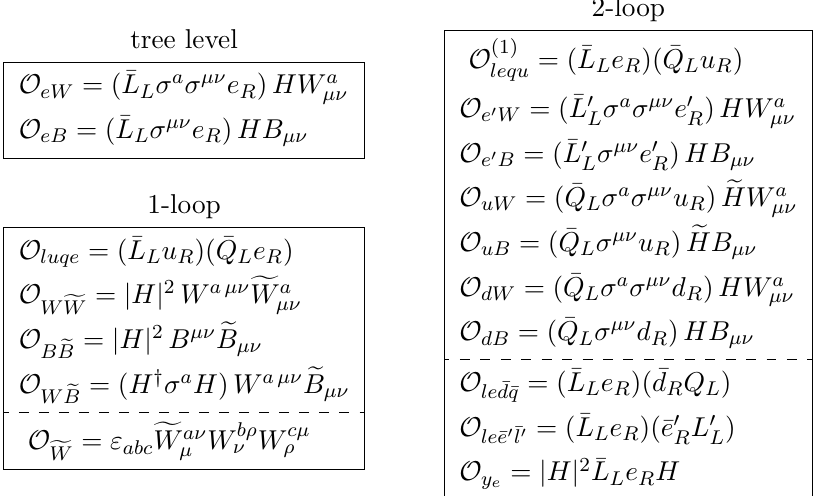
Table 1 . Operators involved in our analysis. Top-left: operators contributing to the electron EDM at tree-level. Bottom-left: operators contributing to the electron EDM at the one-loop level via mixing. Right: operators contributing to the electron EDM at the two-loop level via mixing. In this table we denoted by L L and e R only the (cid:12)rst generation lepton multiplets, while L 0 denote the second and third generation